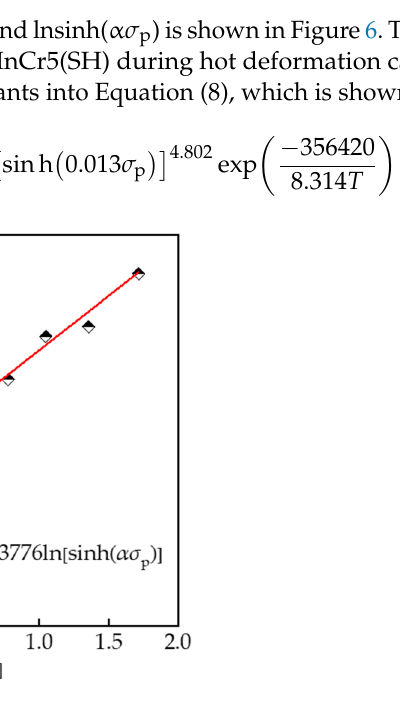
Figure 6. The linear relationships of ln[sinh( ασ p )] and ln